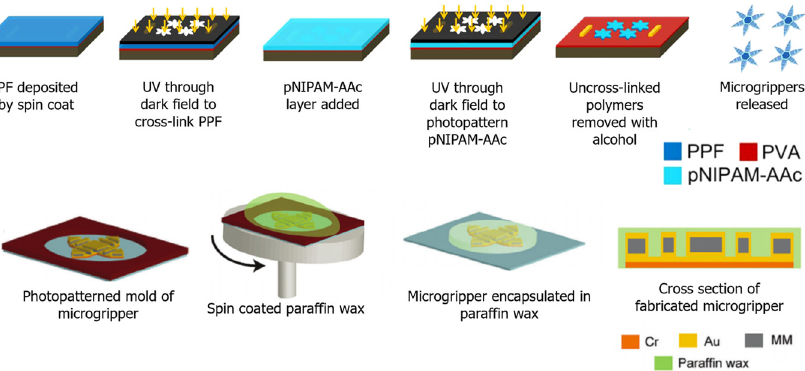
Figure 9. Fabrication of thermomagnetic microgrippers. ( A ) The fabrication process of polymeric microgrippers through serial photolithography. Adapted with permission from Ref. [9].